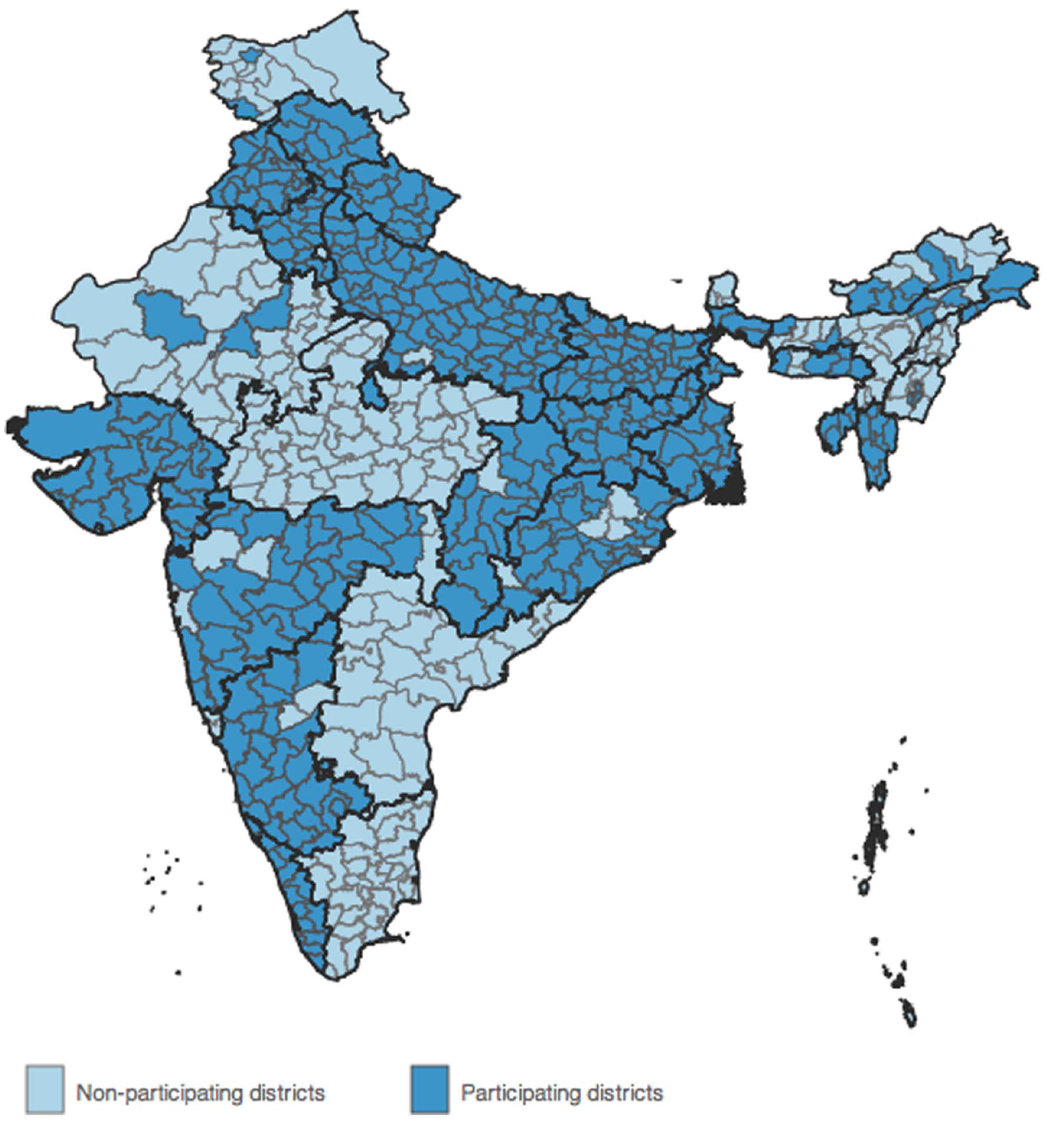
Figure 1. RSBY participating districts. Source: RSBY website (www.rsby.gov.in) downloaded on 22 May 2012. Map created using GADM data.